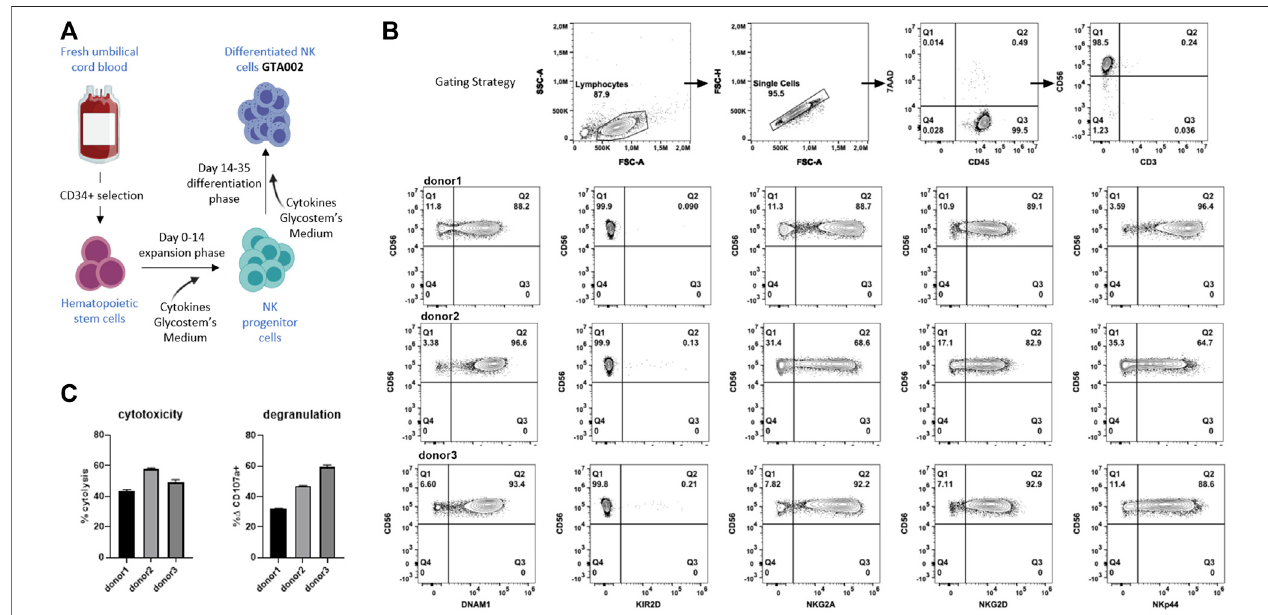
FIGURE5| GenerationandcharacterizationofGTA002 NKcellsusingtheGlycostemuNiK ™ process. (A) Schematicoverviewoftheexpansionanddifferentiation processes of GTA002 NK cells. (B) Representative gating strategy for fl ow cytometry – based characterization of GTA002 NK cells. GTA002 NK cells were gated on CD45 + /7-AAD − cells. NK cell receptor expressions are shown below from three different GTA002 NK cell donors at day 35. (C) Functionality of GTA002 NK cells was determined by cytotoxicity and degranulation assays against K-562 in a 5 h co-culture assay, with E:T of 1:1. Data are shown as the mean ± SEM of technical